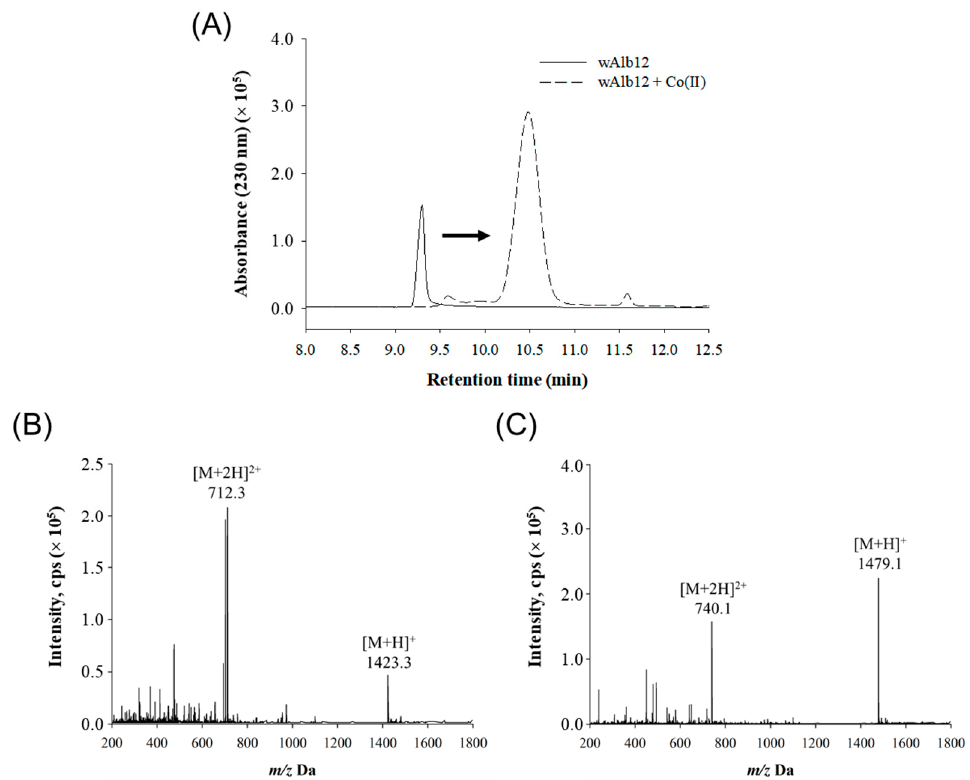
Figure 5. The LC-MS analysis and molecular weights of wAlb12 and wAlb12 + Co(II). ( A ) The HPLC chromatogram of wAlb12 and wAlb12 + Co(II), ( B ) ESI-MS spectrum of wAlb12, and ( C ) ESI-MS spectrum of wAlb12 + Co(II).